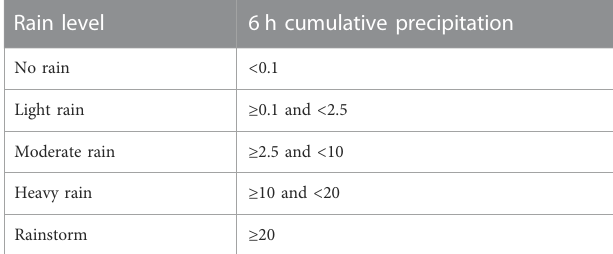
TABLE 2 The gradation of precipitation. Unit: